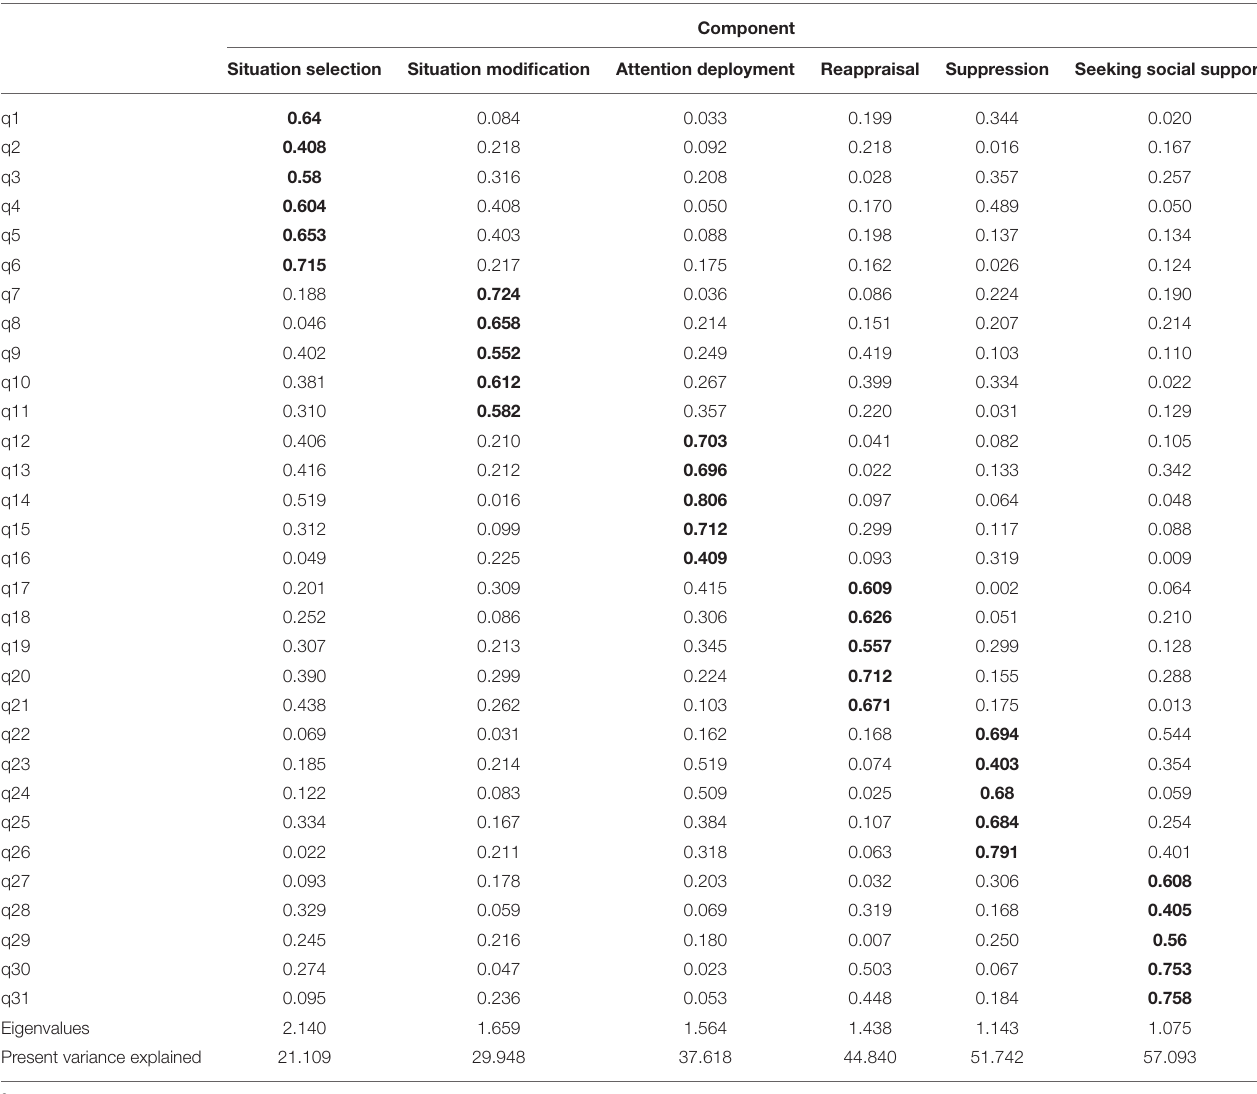
TABLE 3 | The results of exploratory factor analysis. Rotated component matrix a